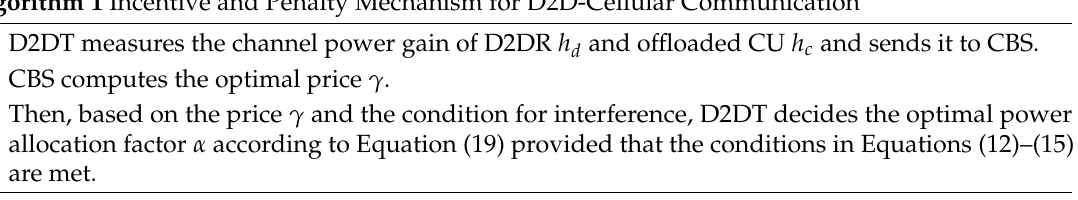
Algorithm 1 Incentive and Penalty Mechanism for D2D-Cellular Communication